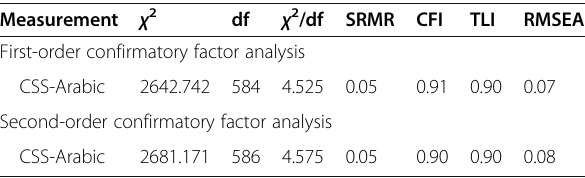
Table 4 Findings of first and second order confirmatory factor